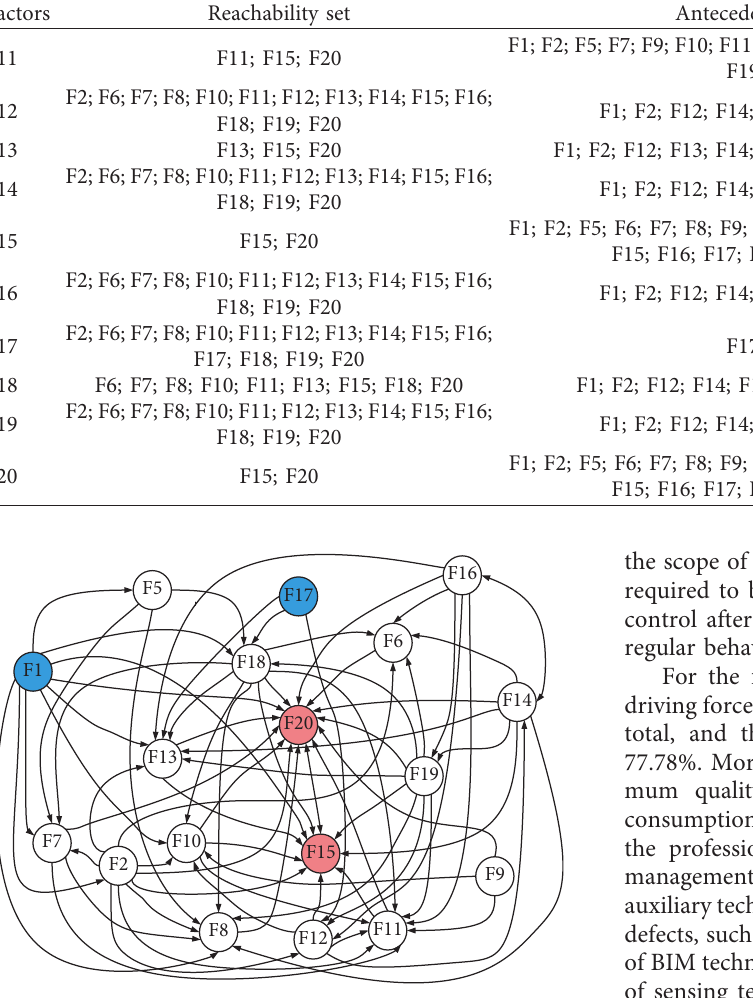
Figure 6: Interrelationships among 18 influencing